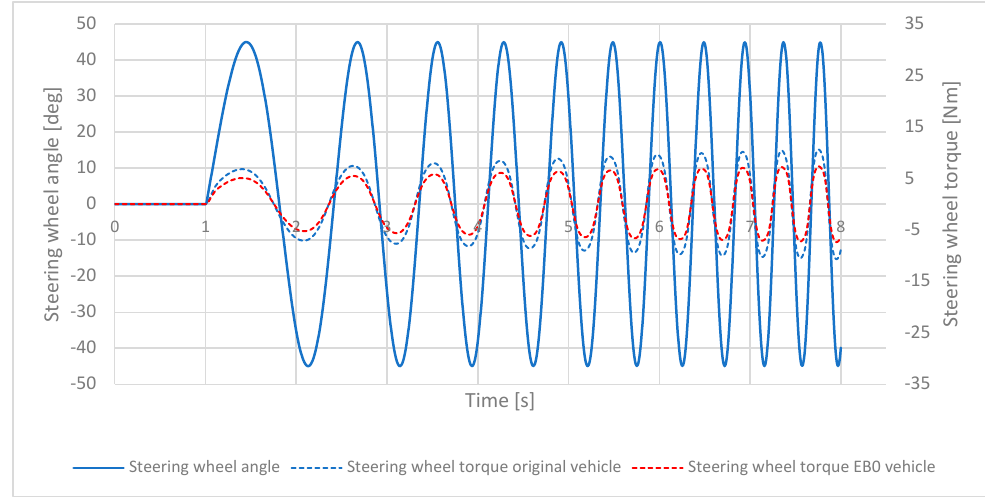
Figure 11. Steering wheel angle for both vehicles (continuous blue line) and steering torque for passive vehicle with original (dotted blue line) and EB0 (dotted red line) suspension.